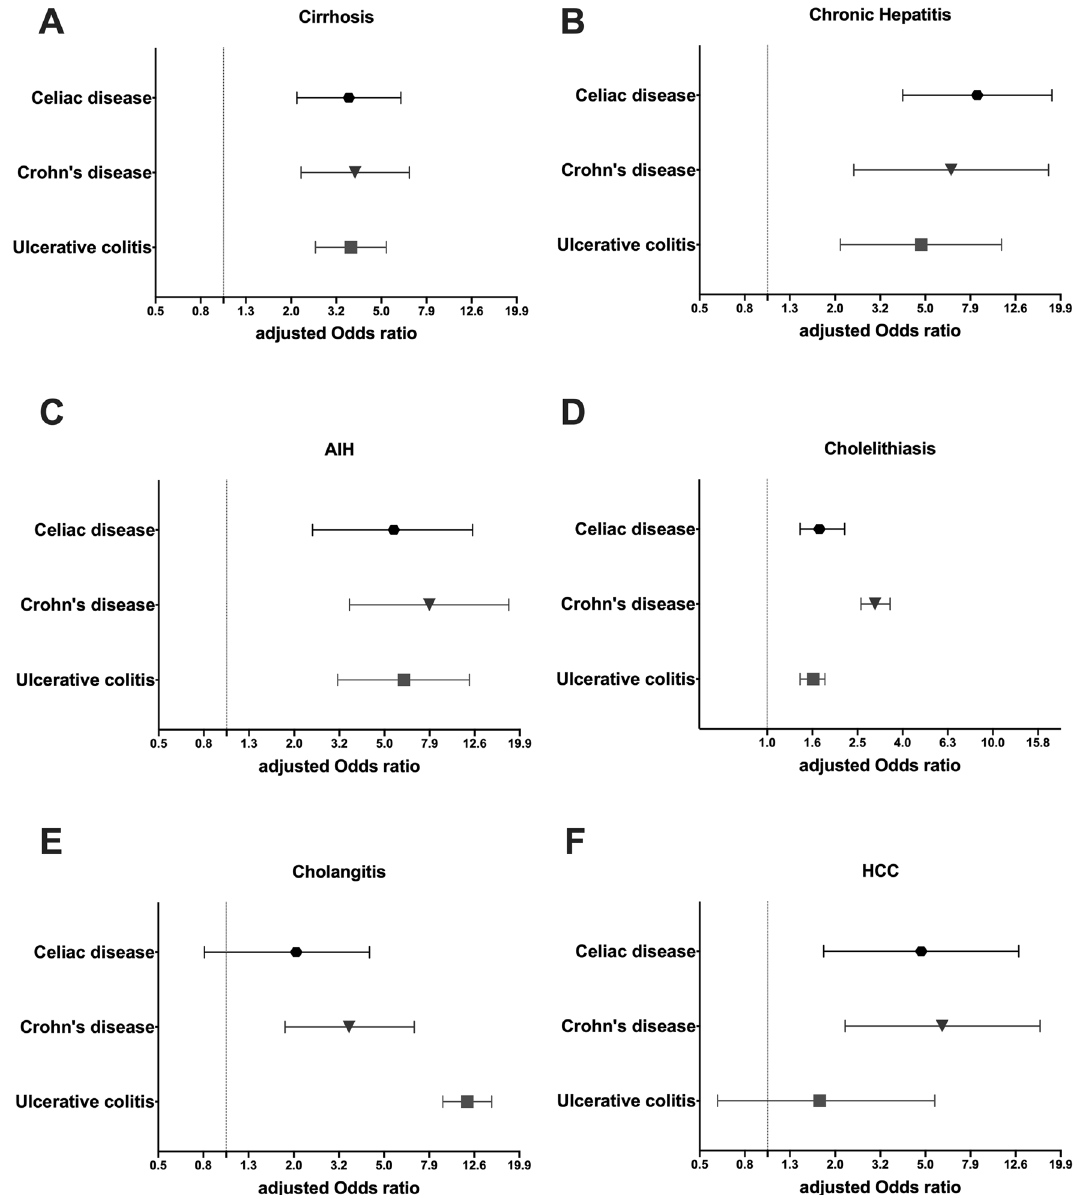
hepatitis (AIH), ( D ) cholelithiasis, ( E ) cholangitis, ( F ) hepatocellular carcinoma (HCC). Adjusted odds ratios (OR) with their corresponding 95% confidence intervals (CI) are shown. Odds ratios were adjusted for age, sex, BMI, alcohol consumption and diabetes